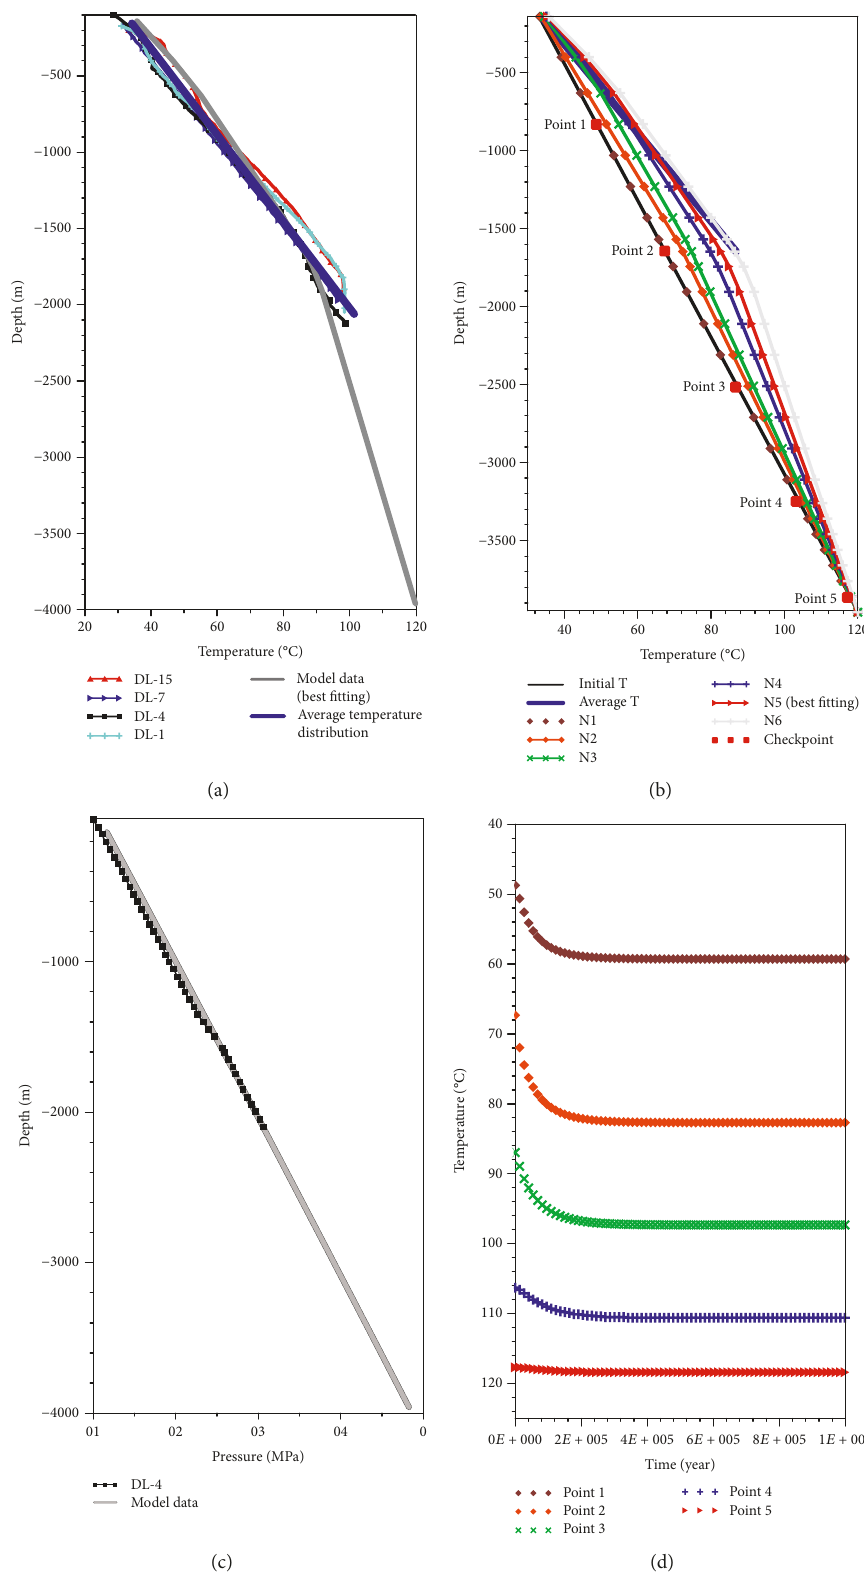
Figure 3: The temperature (a) and pressure (c) measured in the shallow aquifers extended to the deep geothermal reservoir by a 1D natural state model. The steady temperature distribution (b) of cases (N1 – N6) with calibrated heat conductivity. Temperature variation with time (d) of 5 points in